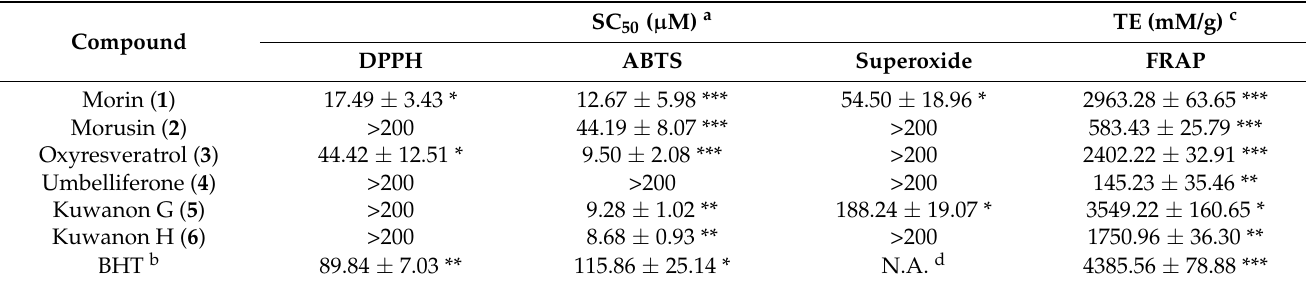
Table 6. Antioxidant activities of isolated components from Morus alba L. determined by DPPH, ABTS, superoxide radical scavenging, and FRAP